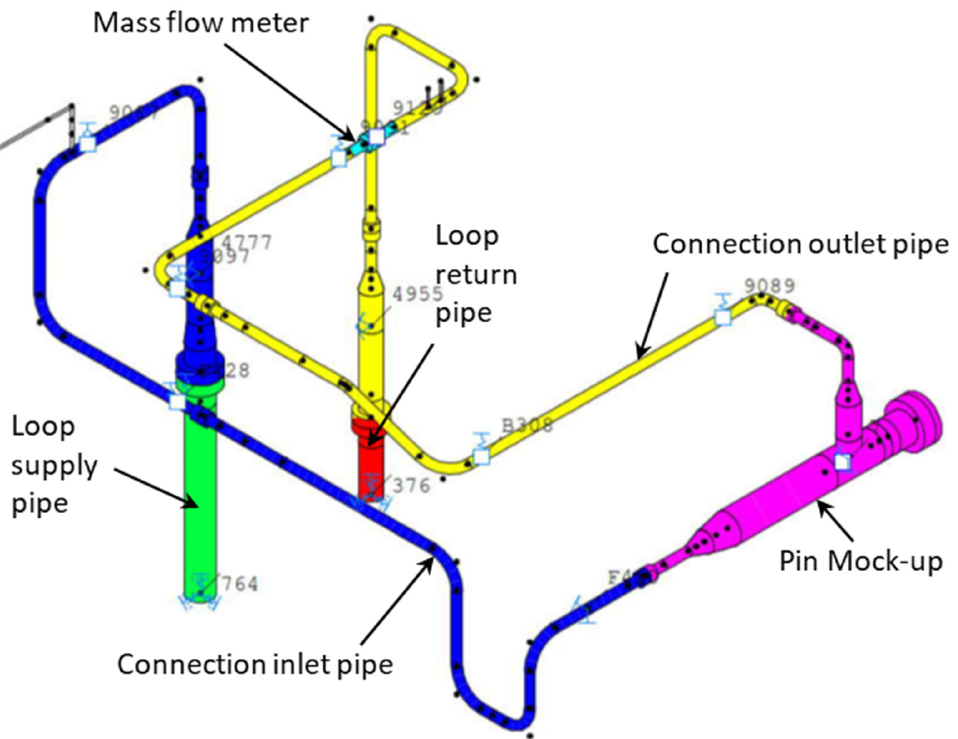
Figure 3. The connection pipes between the mock-up and the loop pipes.